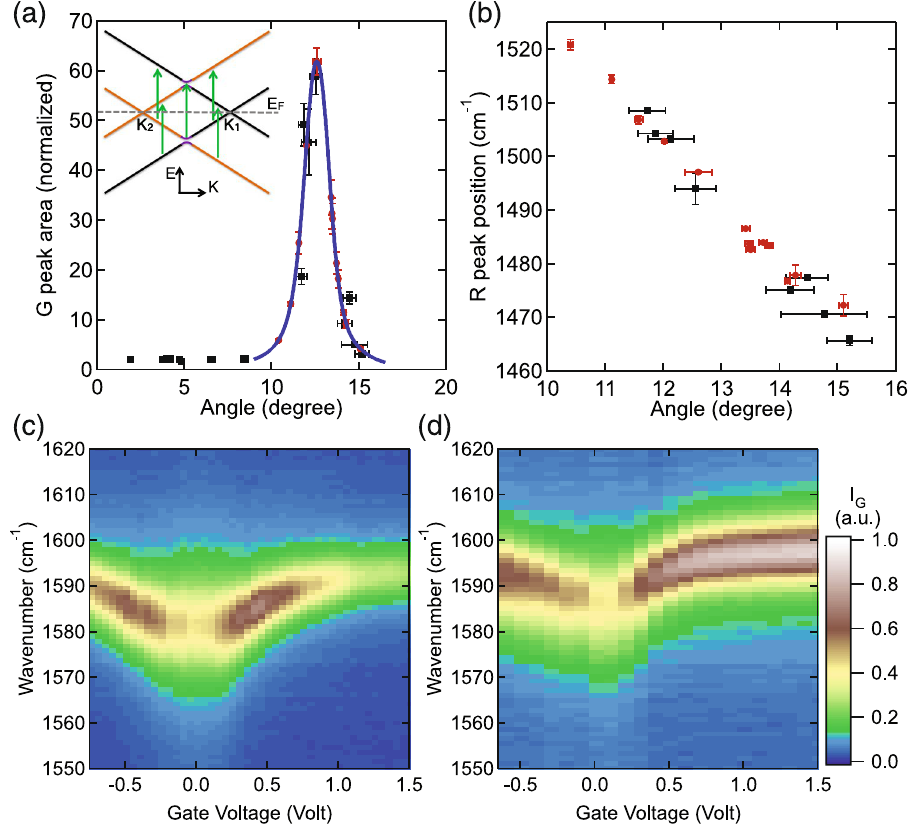
Figure 2. ( a ) Measured Raman G peak area (normalized to that of monolayer) as a function of twist angle. The twist angle for the black points was measured using STM topography. The uncertainty in angle of the black points represents the variation in the atomic lattice length a and moiré pattern wavelength D measured by STM. The blue curve is the theoretical calculation within the angle range where the G peak is enhanced showing that the maximum enhancement occurs at 12.6°. The additional red points were only measured by Raman spectroscopy and their twist angles were determined as discussed in the text. The error bars in G peak area represent the standard deviation of the area of a Lorentzian fit to the G peak. Inset shows Raman pathways that contribute to the enhanced G peak. ( b ) Raman R peak position as a function of twist angle. The error bars in R peak position represent the uncertainty of the peak position when fit with a Lorentzian. ( c ),( d ) Raman intensity near the G peak as a function of wavenumber and gate voltage for 11.1° ( c ) and 14.1° ( d )